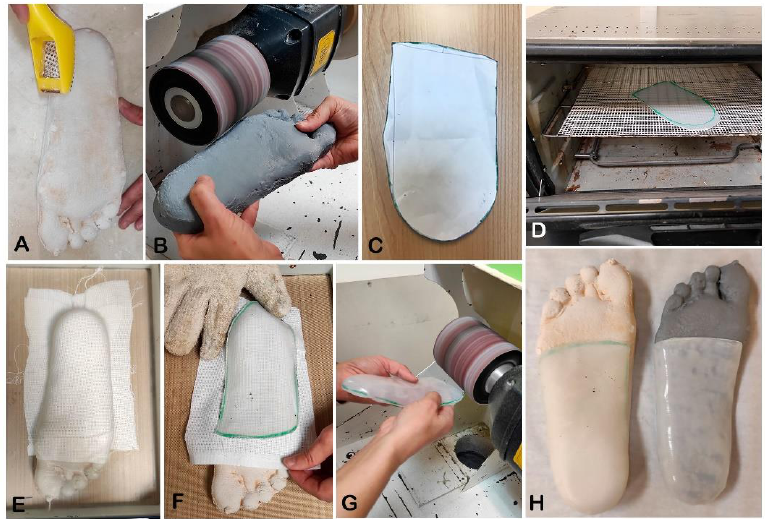
Figure 3. Method for making orthoses in both positive casts following the protocol of Doxey (Doxey 1985) and Levi (Levi Bensauly 2003). A and B: removing the reference points from the positive casts. C: Pattern for cutting out the orthosis materials. D: Polypropylene in the oven. E and F: Fitting the orthoses. G: Polishing the orthoses. H: Orthoses fitted on the positive